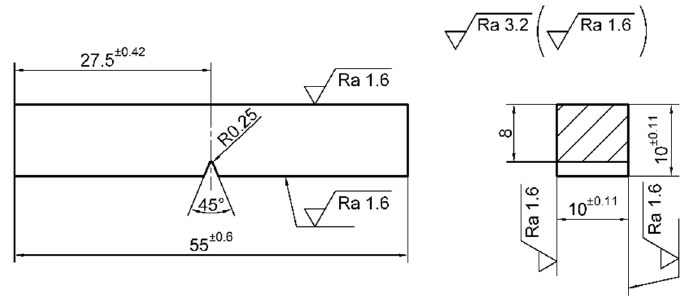
Figure 3. Impact toughness test samples, shape and dimensions.